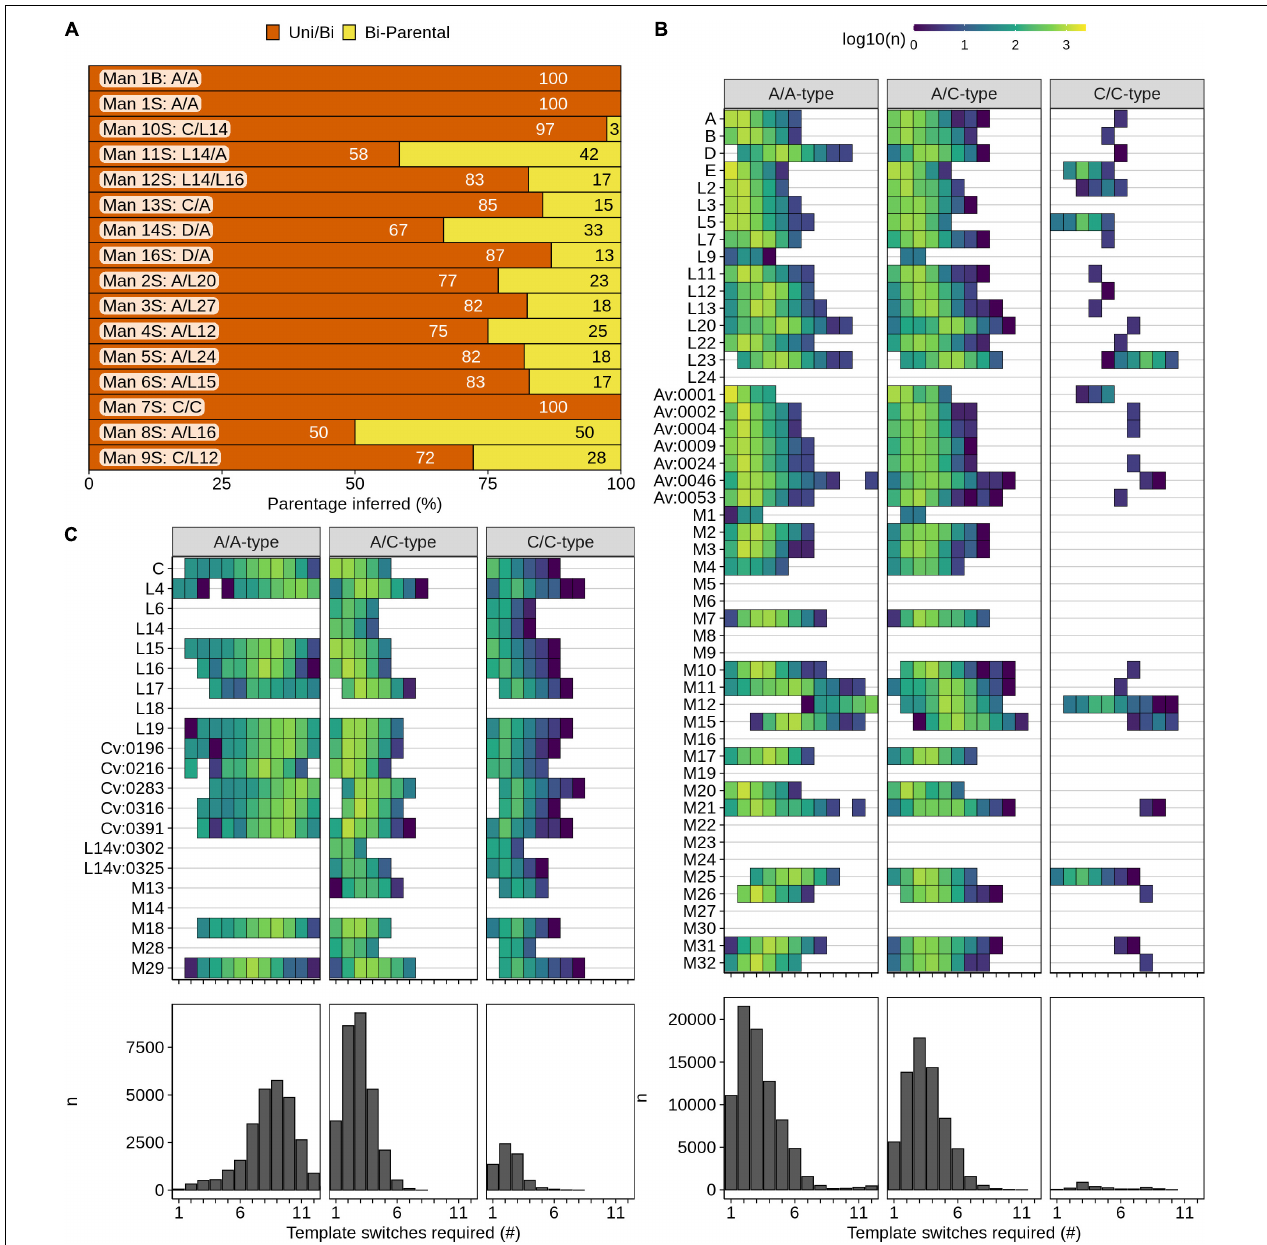
FIGURE 4 | Isolated clusters of A -type and C -type PRDM9 alleles. The PRDM9 ZF array is hypervariable, and variation arises via a poorly understood mechanism. We designed and utilized an algorithm to predict the formation of any PRDM9 allele from any other based on template switching. (A) Most PRDM9 variants in human blood or sperm can be explained by template switches between the two parental PRDM9 alleles. If several combinations of parental alleles are possible, we identified the “most-likely” recombinant, which required the minimal number of template switches. For each individual, we quantified the alleles where this “most-likely” recombinant is derived from either both parental alleles (bi-parental) or where a uni- and bi-parental origin are equally possible (Uni/Bi). (B) A -type PRDM9 alleles rarely arise from C -type alleles, and (C) C -type PRDM9 alleles can arise from A -type alleles but mostly require highly complex template switches. (B,C) We searched for potential parental alleles for each A -type (B) and C -type (C) PRDM9 allele. All alleles found in human populations or in blood/sperm only were considered. Heatmaps show the number of potential parental combinations for each number of template switches. Columns represent events in A -type homozygotes, A -type/ C -type heterozygotes, or C -type homozygotes. Quantitation of all events is shown in bar plots underneath.